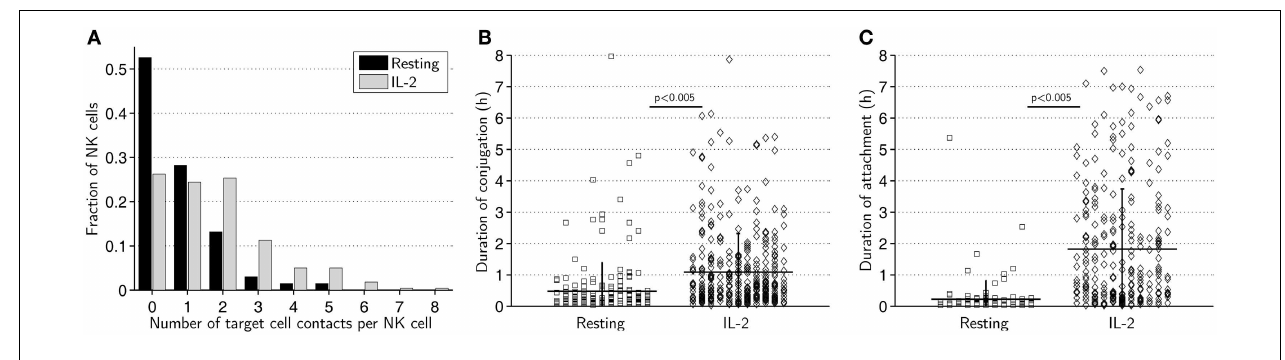
activated NK cells. (B) Duration of conjugation periods for resting (squares, left) and activated (diamonds, right) NK cells. (C) Duration of attachment periods for resting (squares, left) and activated (diamonds, right) NK